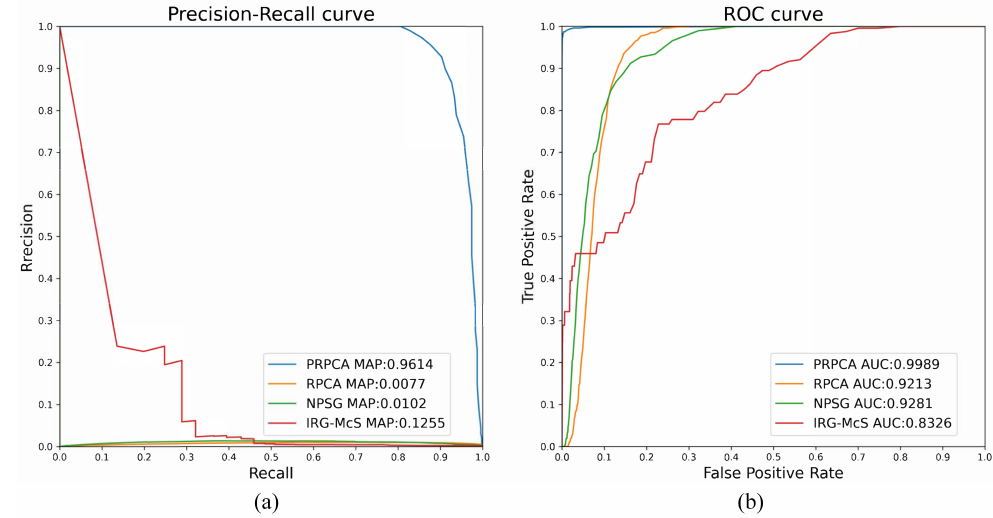
Figure 8. ROC and PR curve results of the image pair with small lesions. ( a ) PR curve; and ( b ) ROC curve.